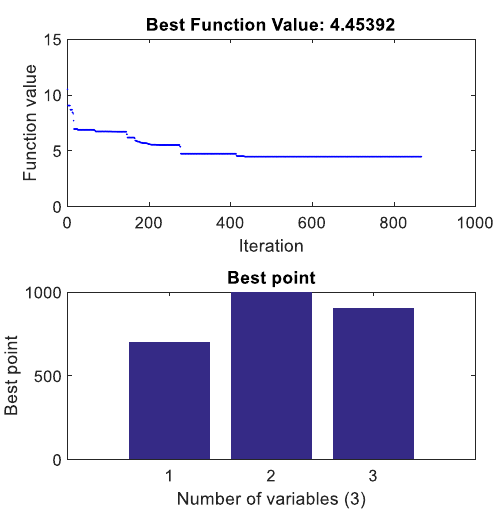
Figure 10. Optimization process.